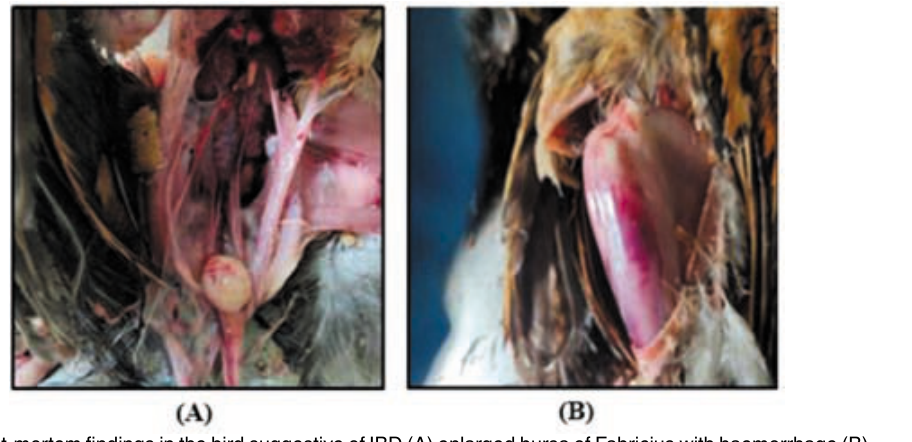
Fig.1. Post-mortem findings in the bird suggestive of IBD (A) enlarged bursa of Fabricius with haemorrhage (B) haemorrhages in the leg